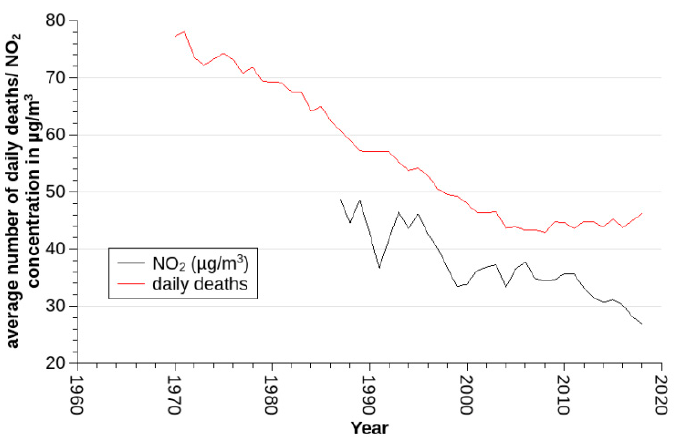
Figure 2. Average daily number of deaths (number) and concentration of NO 2 (µg/m 3 ) per year. Table 2. Effect estimates (% change per 10 µg/m 3 NO 2 ).